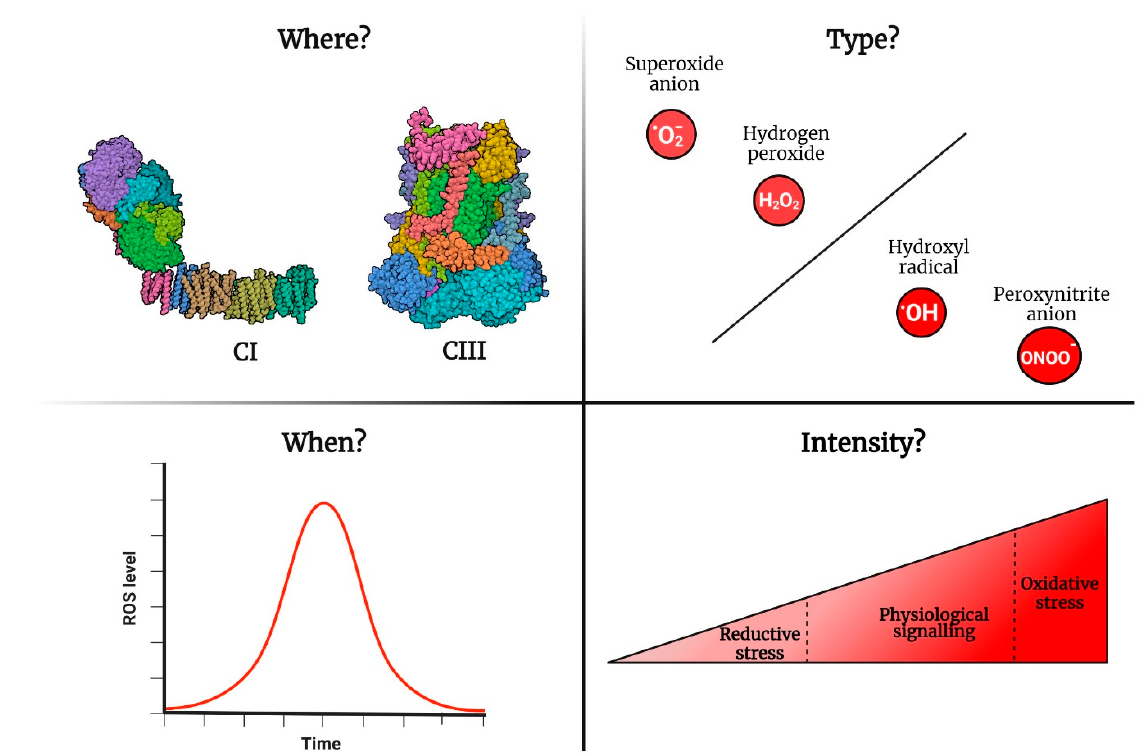
Figure 3. The four aspects of an mtROS signal that impact its downstream effects. “Where” indicates that ROS produced by complexes I and III participate in various physiological and pathological processes. “When” refers to the temporal dynamics of mtROS signalling and highlights the importance of understanding how the signal is initiated and terminated using kinetic measurements rather than a single-point measurement. “Type” explains that mtROS signalling is mainly mediated by low reactive species, such as superoxide and hydrogen peroxide, while highly reactive species, such as hydroxyl radical, are responsible for oxidative damage. Finally, “Intensity” emphasizes that the intensity of mtROS signals needs to be within an appropriate physiological range to avoid disrupting cellular homeostasis by triggering oxidative or reductive stress. The figure illustrates the interplay between these four aspects of mtROS signalling and their downstream effects.